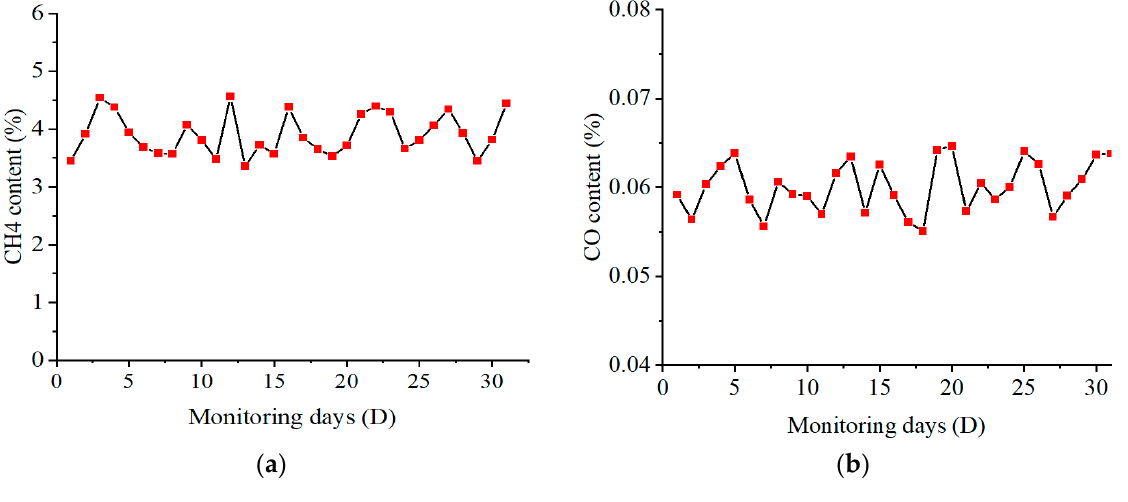
Figure 21. Harmful gas monitoring over a period of one month. ( a ) CH 4 , ( b )